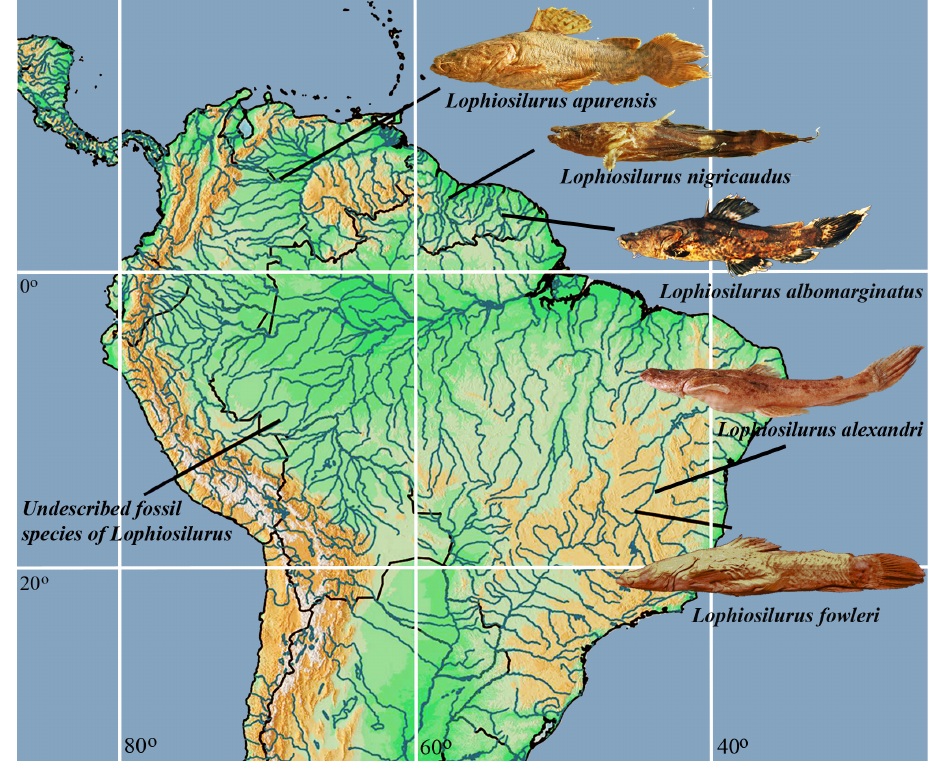
FIGURE 1 | Geographic distribution of Lophiosilurus species. Lophiosilurus apurensis , MZUEL 6492, 189.7 mm SL, Apure river basin, Venezuela; L. nigricaudus , INPA 21632, 58.1 mm SL, Sipaliwini river basin, Suriname; L. albomarginatus , ROM 61336, 88.4 mm SL, Tukeit river basin, Guyana; L. alexandri , MZUEL 5377, 157.8 mm SL, São Francisco river basin, Brazil; L. fowleri , FMNH 54254, holotype, 301.4 mm SL, São Francisco river basin,